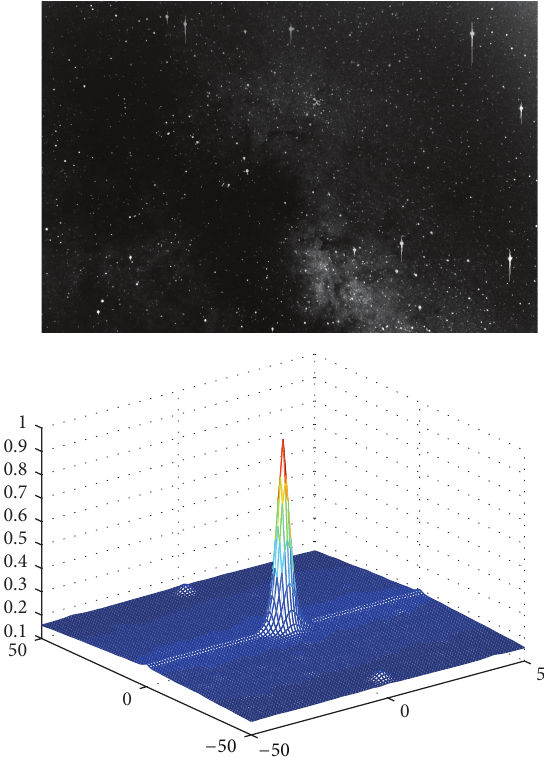
Figure 2: Image from wide field camera M7 and Milky Way with many small objects (less than 10 pixels) and its autocorrelation